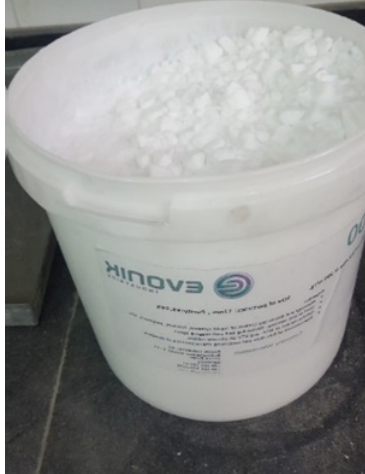
Figure 2. The nano-silica powder.